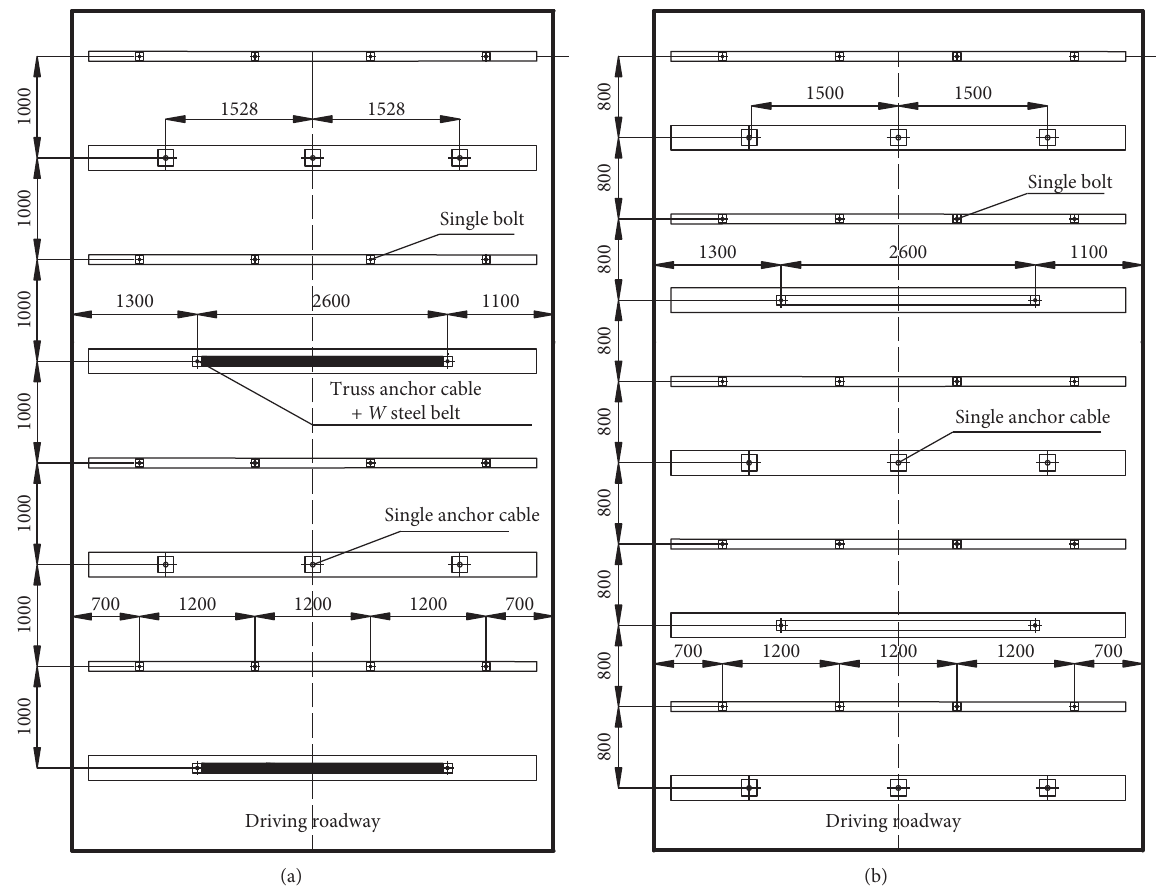
Figure 13: Top view of roadway roof support. (a) New roof support parameters. (b) Original roof support